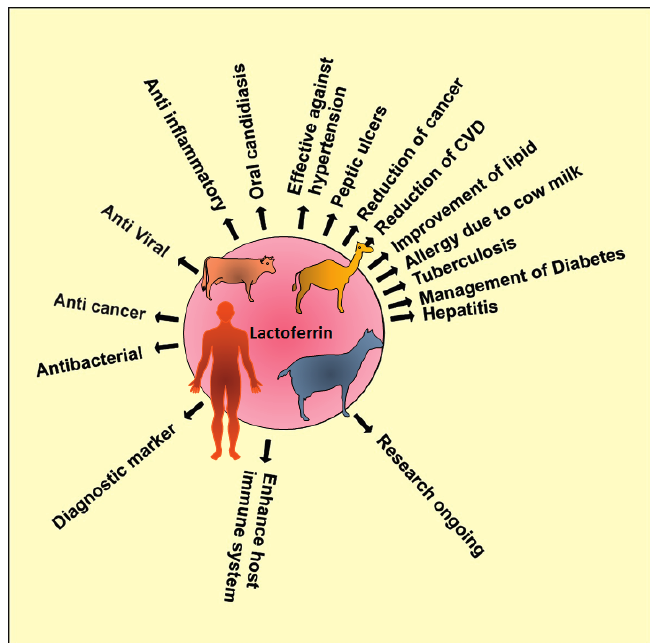
Figure 1. Lactoferrin and its functions. Lf from bovine source is a promising candidate